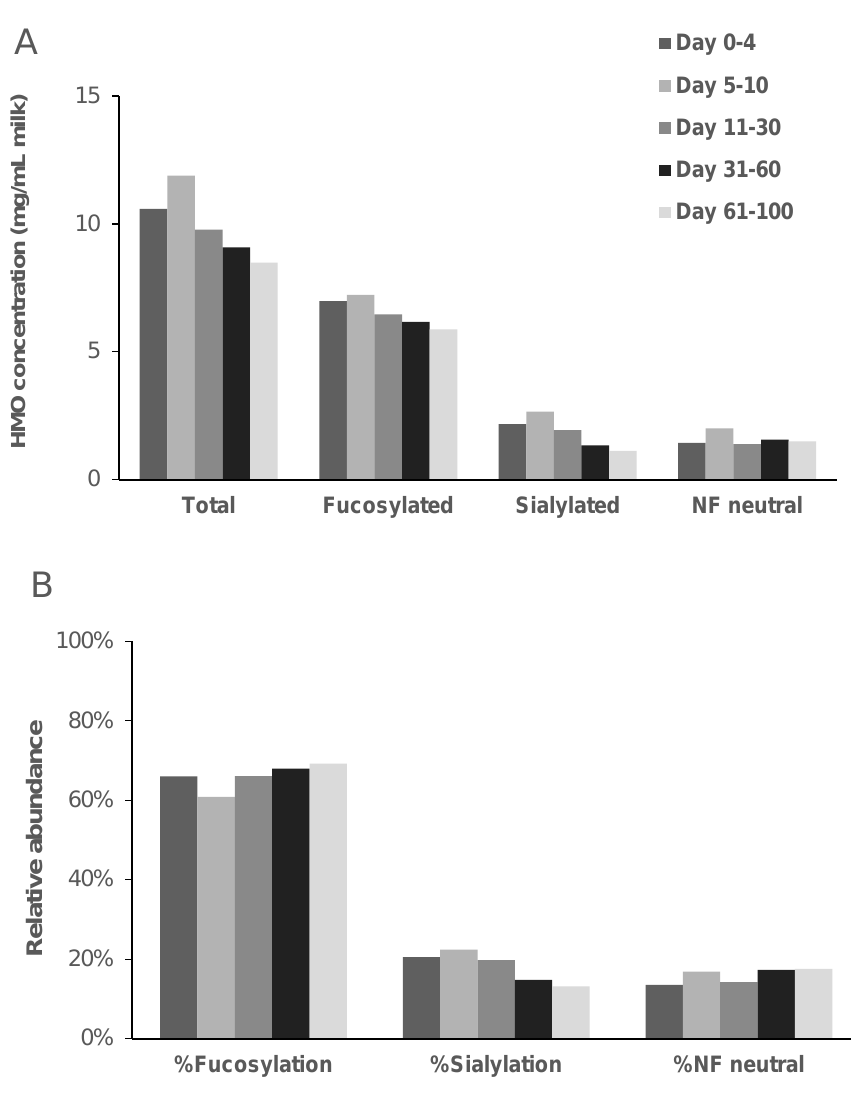
Figure 2. Changes in absolute ( A ) and relative ( B ) concentrations of human milk oligosaccharides (HMOs) from secretor mothers during the course of lactation. ( A ) Total, fucosylated, sialylated, non-fucosylated neutral HMO concentrations decreased over time. ( B ) Percentage of fucosylation increased while percentage of sialylation decreased and non-fucosylated neutrals remained stable over time. NF, non-fucosylated neutral oligosaccharides; The data were compiled by Thurl et al., (2017) [2].